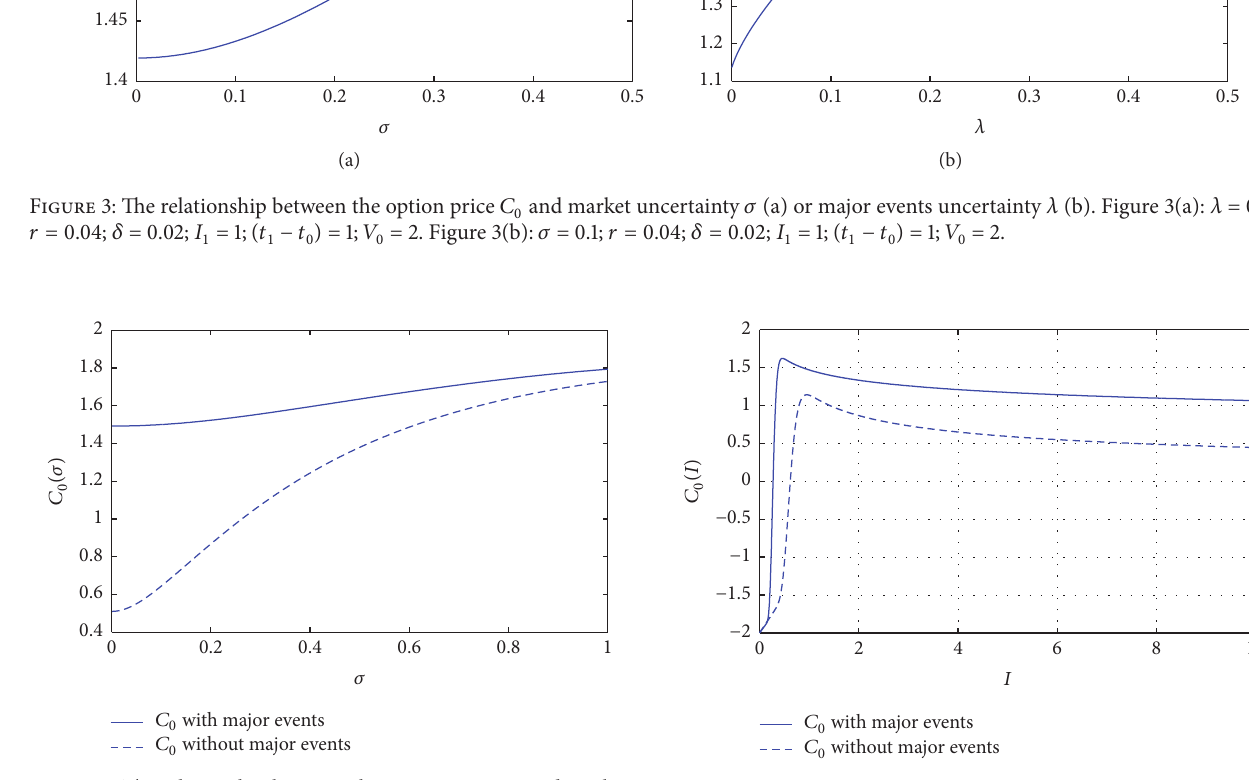
Figure 4: The relationship between the option price 𝐶 0 and market Figure 5: The relationship between the option price 𝐶 0 and the uncertainty 𝜎 with (solid line) or without (dashed line) major events second phases fund of size 𝐼 1 with (solid line) or without (dashed uncertainties 𝜆 . Solid line: 𝜆 = 0.2; 𝑟 = 0.04 ; 𝛿 = 0.02; 𝑉 0 = 2; 𝑡 1 −𝑡 0 = line) major events uncertainties 𝜆 . Solid line: 𝜆 = 0.1; 𝑟 = 0.04 ; 𝛿 = 1 ; 𝐼 𝜆 = 0; 𝑟 = 0.04 ; 𝛿 = 0.02 ; 𝑉 𝑡 − 𝑡 = 1 ; 𝐼 0.02; 𝑉 0 = 2; 𝑡 1 − 𝑡 0 = 1 . Dashed line: 𝜆 = 0; 𝑟 = 0.04 ; 𝛿 = 0.02 ; 𝑉 0 = 1 = 2. Dashed line: 0 = 2; 1 0 1 = 2. 2; 𝑡 1 − 𝑡 0 = 1